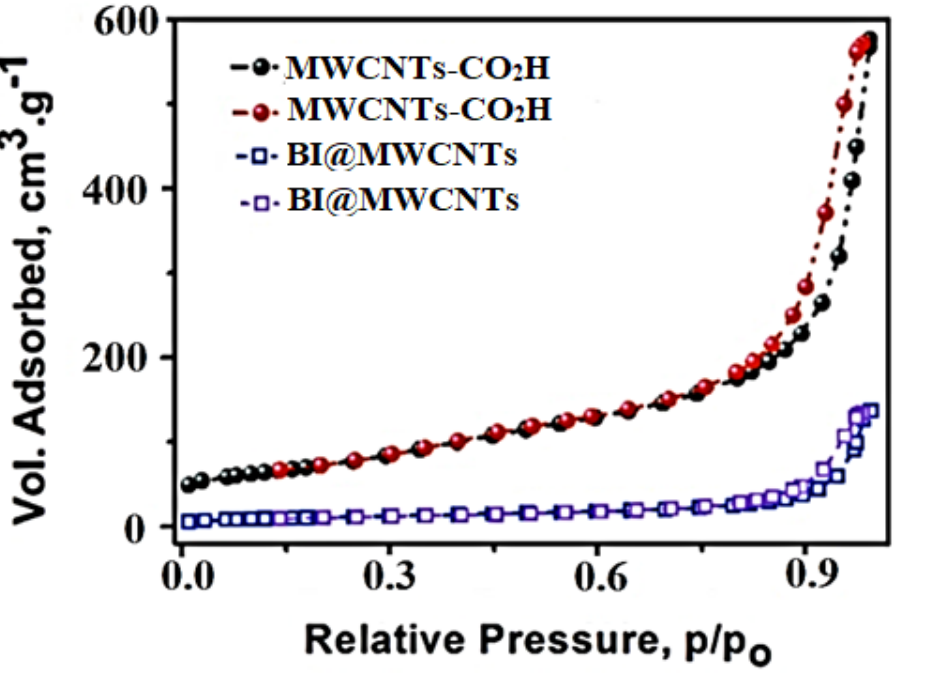
Figure 6. N 2 adsorption – desorption isotherms of MWCNTs – CO 2 H and BI@MWCNTs. Table 1. Surface area of MWCNTs – CO 2 H and BI@MWCNTs.